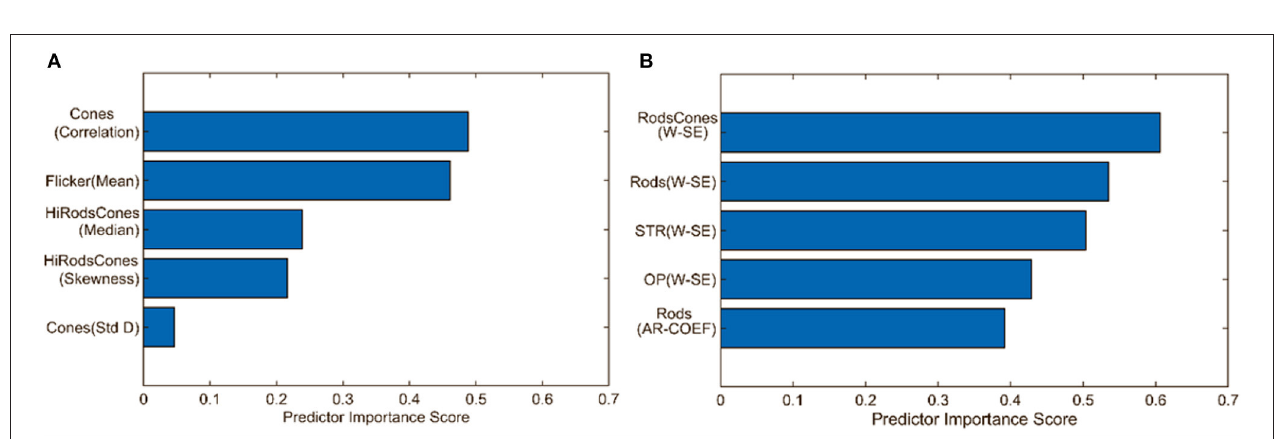
FIGURE 6 | Boxplot of statistically important features for binary classification. The important features capable of distinguishing healthy and glaucomatous are correlated feature from Cones, third order Moment and trimmed mean feature from Oscillatory Potentials (OP) and Range and aspect ratio from Scotopic Threshold Response (STR). However, the high similarity between these features quantified by the correlation scores in the scatter plot create redundancy (inclusion cones(correlation) feature alone vs inclusion all five features does not improve accuracy). Therefore, utilizing the cones correlation feature alone captures the behavior of the other four features. This dropping of redundant features and choosing Cones (correlation) feature alone is achieved by using Minimum Redundancy and Maximum Relevance (MRMR) algorithm (On each box, the central mark indicates the median, and the bottom and top edges of the box indicate the 25th and 75th percentiles, respectively. The whiskers extend to the most extreme data points not considered outliers, and the outliers are plotted individually using the “+” marker symbol.).